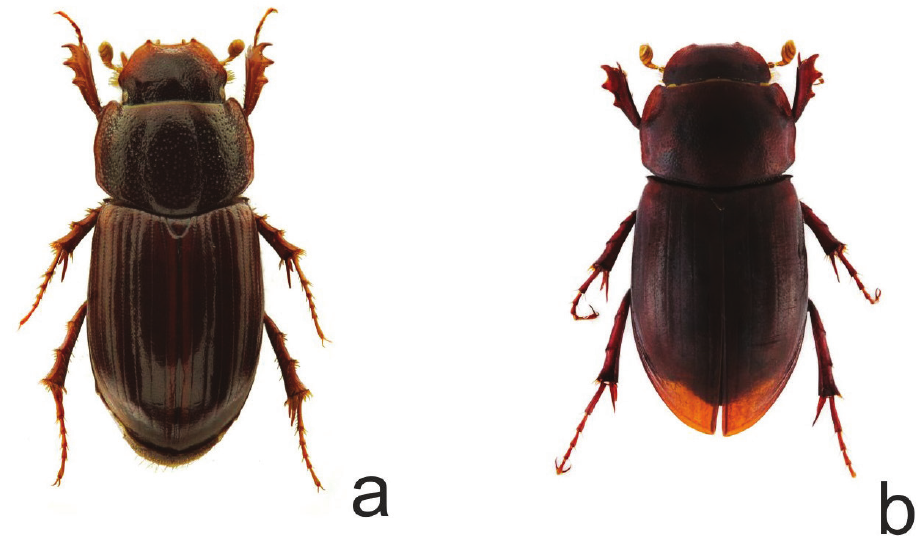
Figure 3. Habitus of adults a G. pierai b G. barrerai